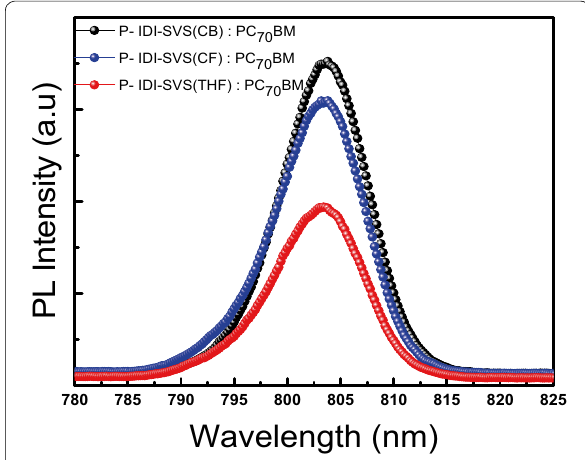
Fig. 6 Impedance spectra of P‑IDI‑SVS(THF):PC 70 BM BHJ solar cell with different solvents (CB,